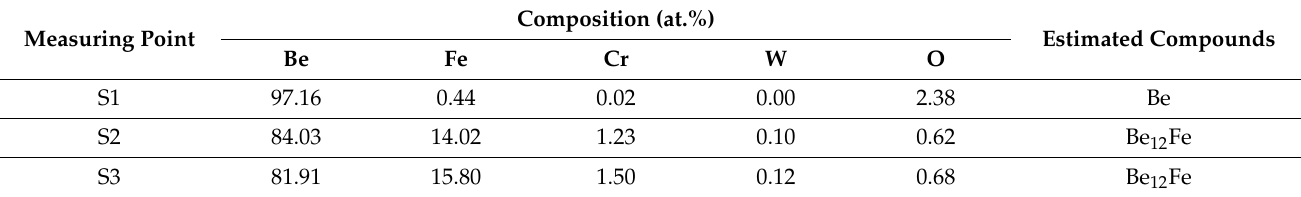
Estimated Compounds